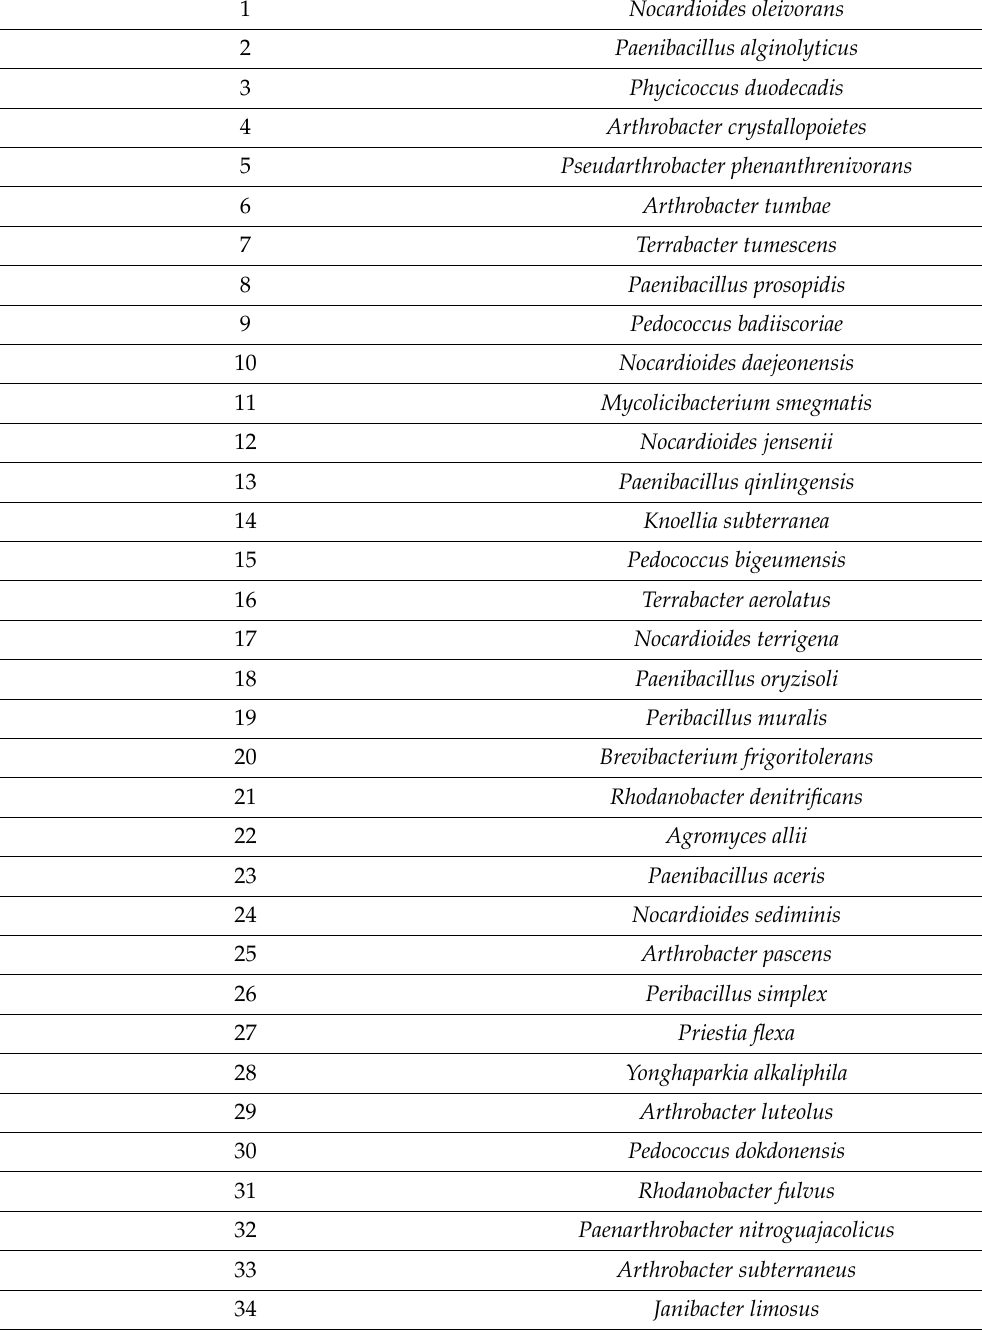
Table A2. The detail of Figure